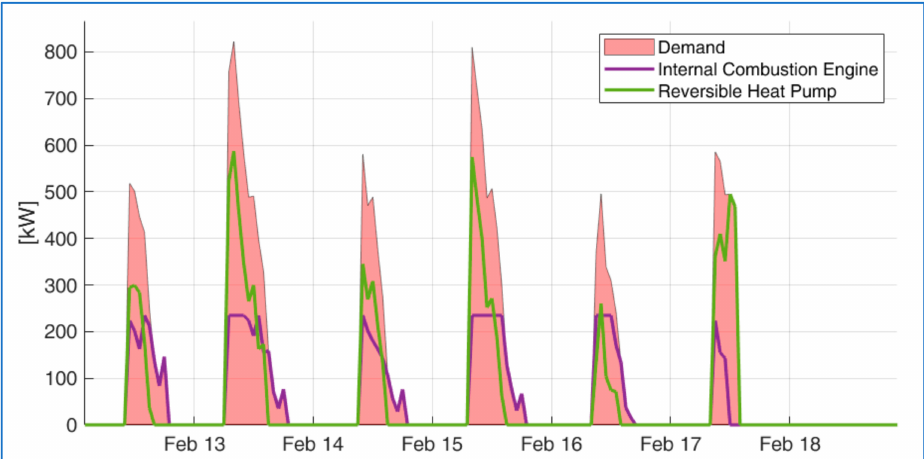
Figure 9. Optimal operation: heating demand and load shares in a typical week.